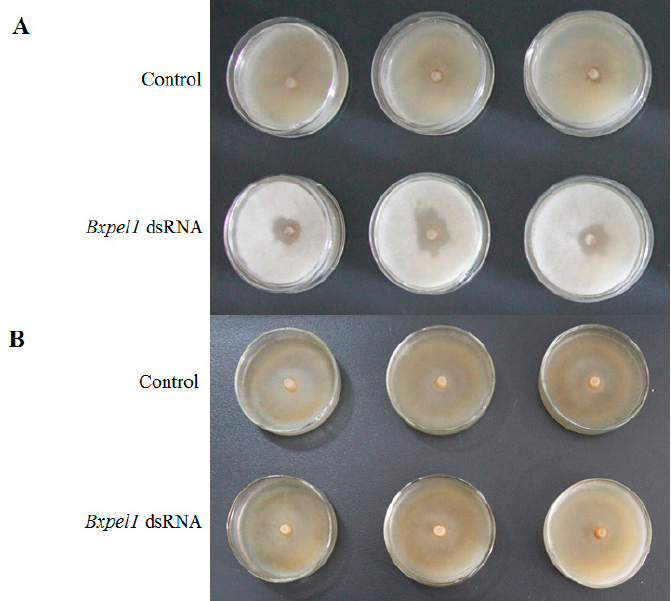
Figure 3. Effects of double-stranded RNA interference (dsRNAi) on B. xylophilus propagation. ( A ) The growth of the first generation of B. xylophilus on B. cinerea ; ( B ) The growth of the second generation of B. xylophilus on B. cinerea.